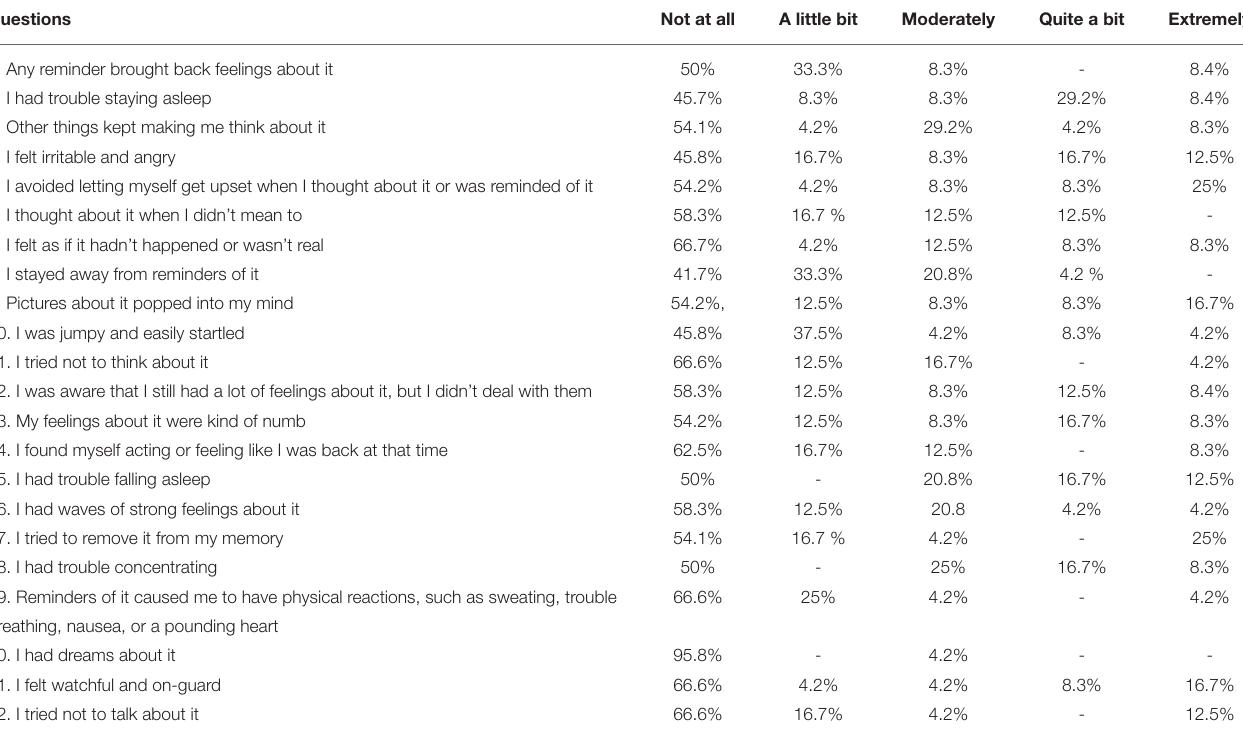
TABLE 2 | Itemized response of participants for each questions of IES-R.